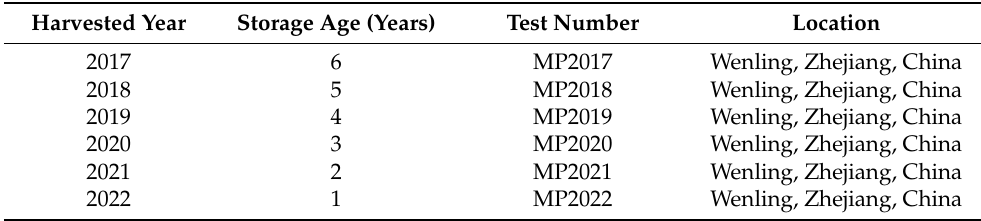
Table 1. The experimental materials used in the experiment. Harvested Year Storage Age (Years) Test Number